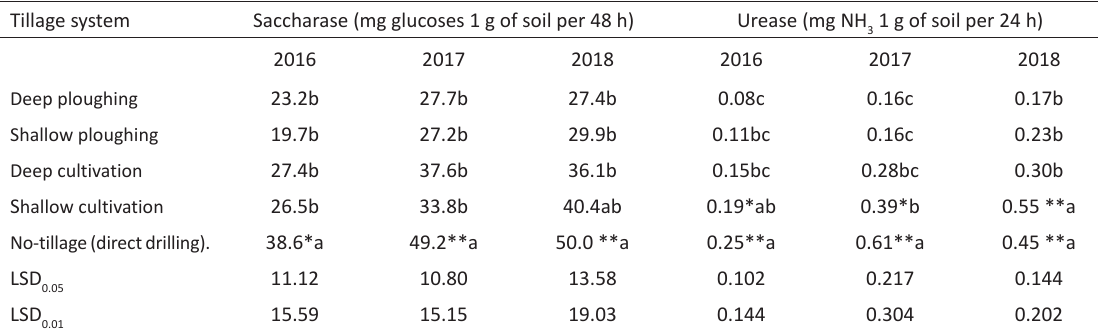
Table 6. Effect of different tillage practise on soil enzymatic activity Tillage system